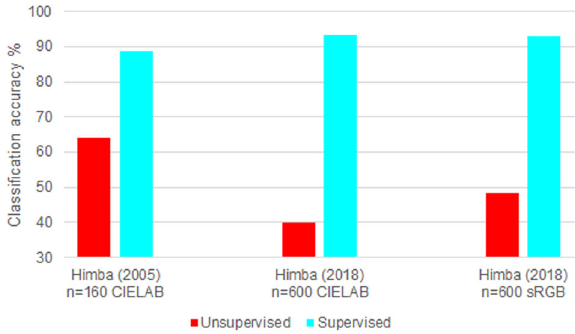
Fig. 5 Comparison of supervised (RST) and unsupervised ( k -means) machine-learning methods for the earlier Himba dataset on the surface of the Munsell system n = 160 (Roberson et al., 2005; left) and the current Himba data across the Munsell system, n = 600 in CIELAB (middle) and in sRGB colour spaces